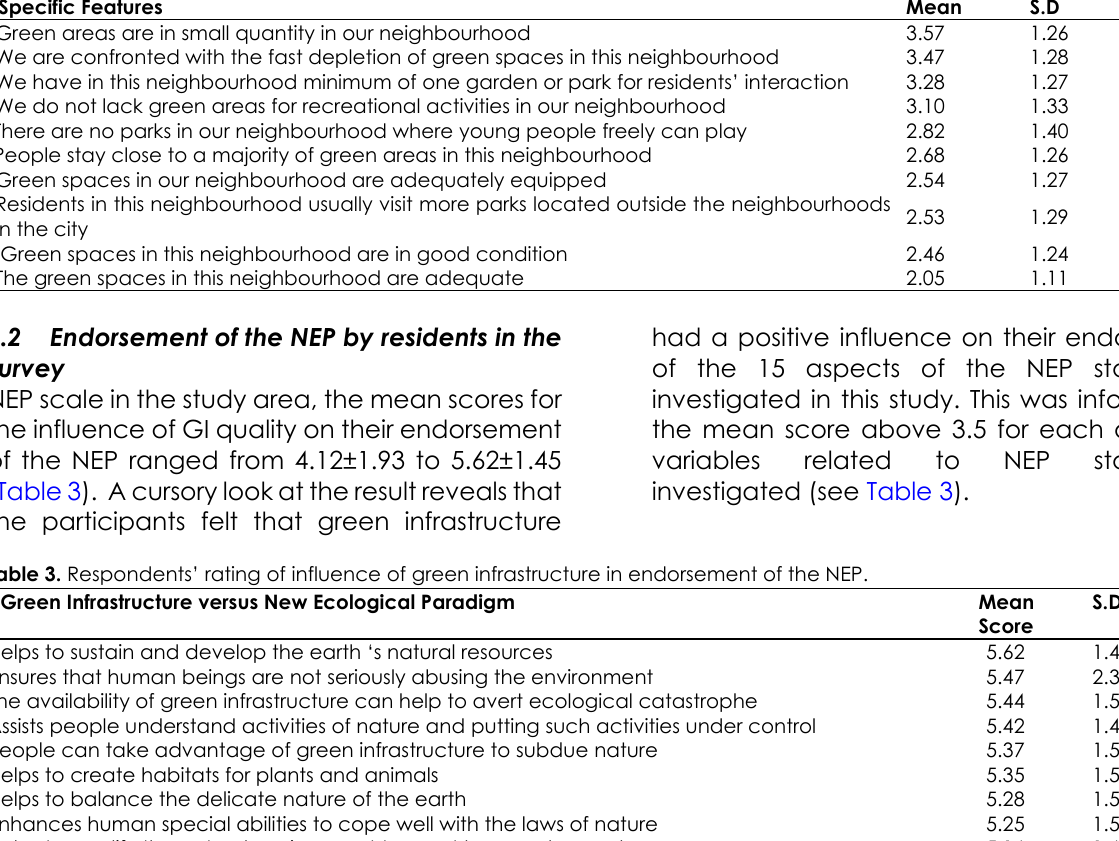
Table 2. Residents’ rating of the features of Green Infrastructure . Specific Features